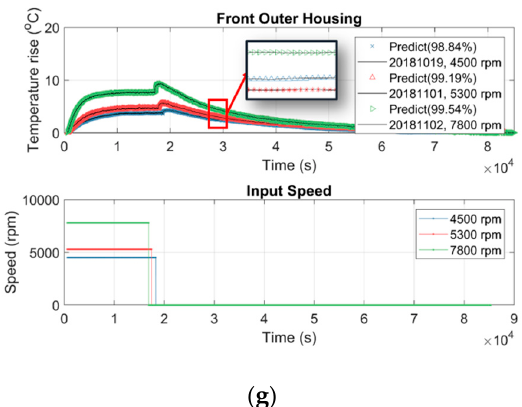
Figure 18. Using the thermal-feature model of the spindle to predict the temperature variation at: ( a ) rear bearing A; ( b ) rear bearing B; ( c ) front bearing C; ( d ) front bearing D; ( e ) inner housing mid; ( f ) rear outer housing, ( g ) front outer housing.